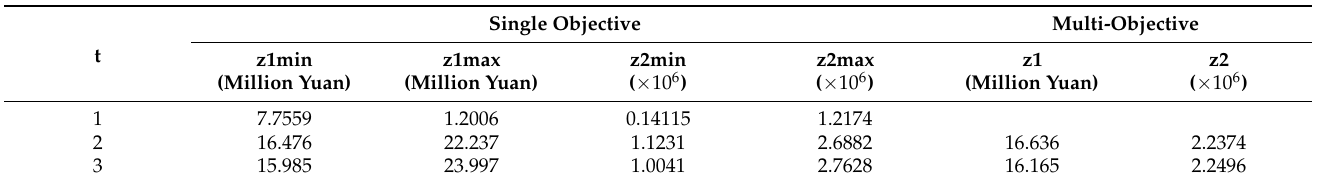
Table 6. Value of objectives.